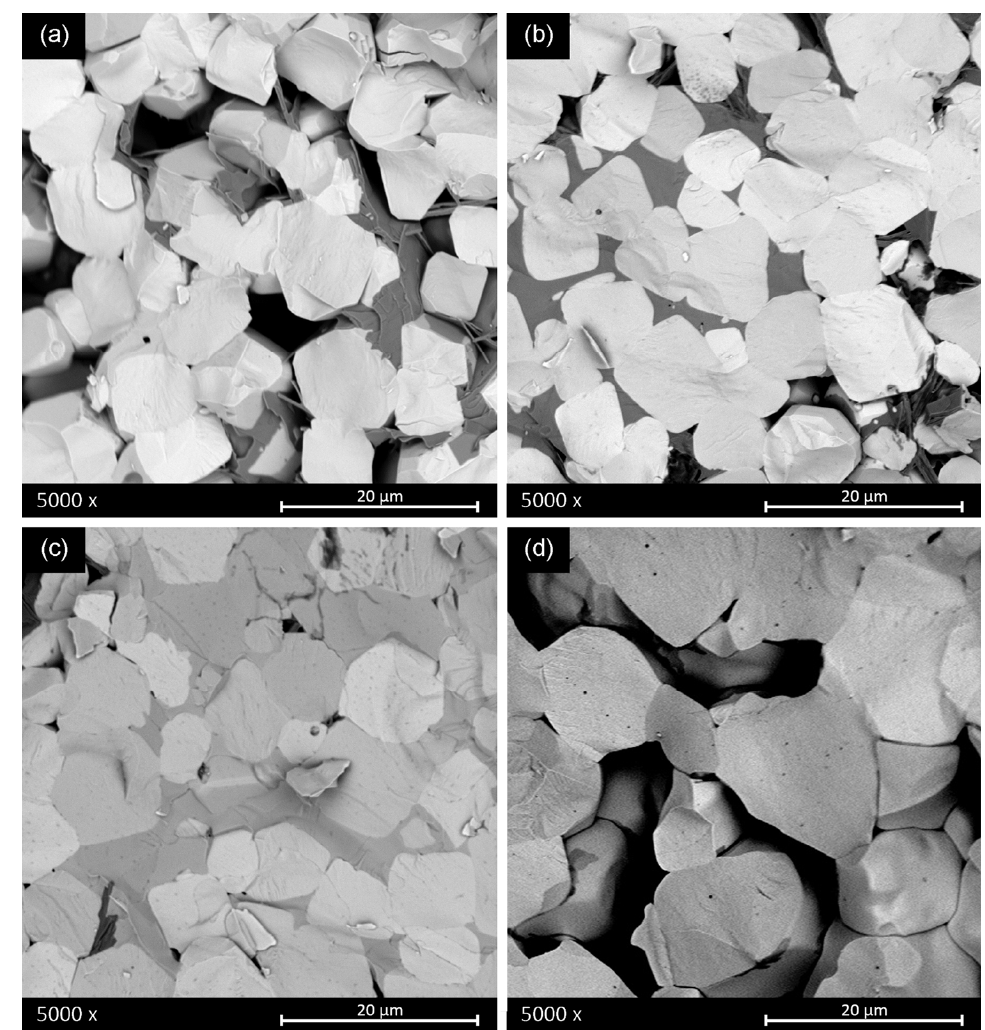
Figure 8. Scanning electron micrographs of the sintered ceramics obtained from powder calcined at 700 °C and subsequent sintering of the pellets at different sintering times and temperatures using a two-step sintering method: ( a ) 900 °C for 1 h/1280 °C for 2 h ( b ) 900 °C for 1 h/1280 °C for 4 h ( c ) 900 °C for 2 h/1280 °C for 6 h and ( d ) 900 °C for 4h/1280 °C for 6 h.